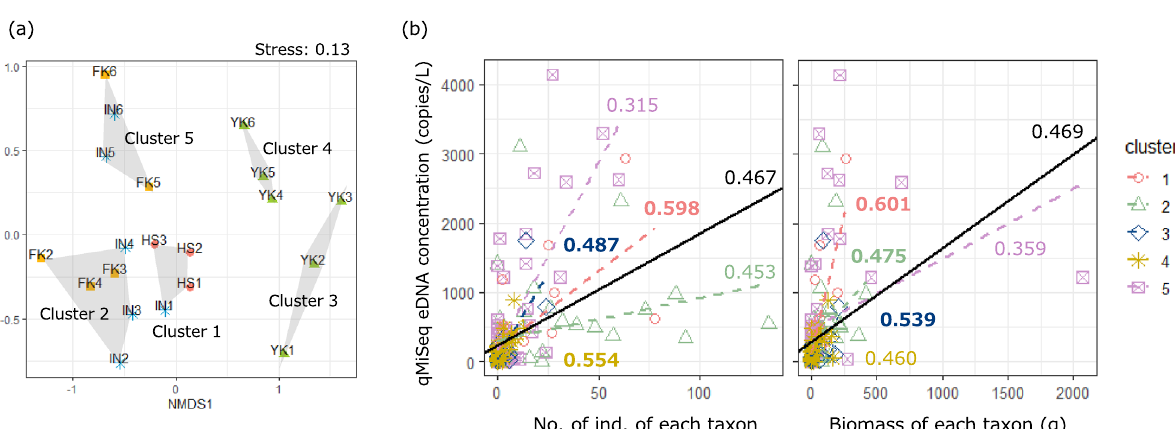
Figure 4. Visualisation of fish communities detected by qMiSeq approach at each study site: ( a ) Nonmetric multidimensional scaling (NMDS) ordination plot of fish communities and ( b ) relationship between the qMiSeq eDNA concentration and the abundance or biomass of each taxon for all study sites and study sites included in each site cluster. NMDS ordination plot and site clustering in (a) panel were based on Bray–Curtis dissimilarity index and k-means clustering. Solid black line in ( b ) panels indicates a linear regression line obtained using all study site data. Coloured dashed lines indicate linear regression lines obtained using each cluster site data. Coloured letters next to regression lines indicate the rank correlation coefficients (Kendall’s τ). If the Kendall’s τ value obtained using data from each cluster site was greater than that obtained using data from all study sites, the rank correlation coefficients were expressed in